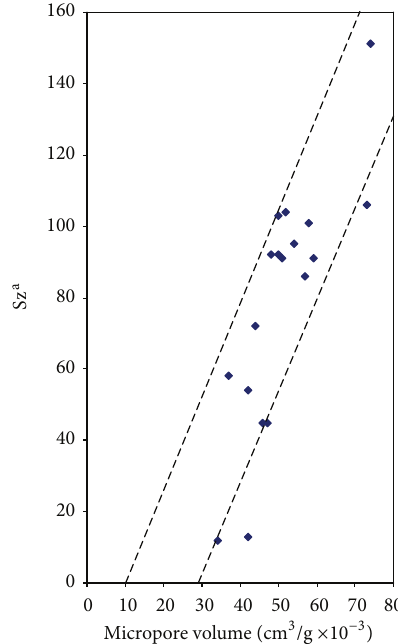
Figure 1: Value of spontaneous combustion index Sz a of coal as a function of micropore